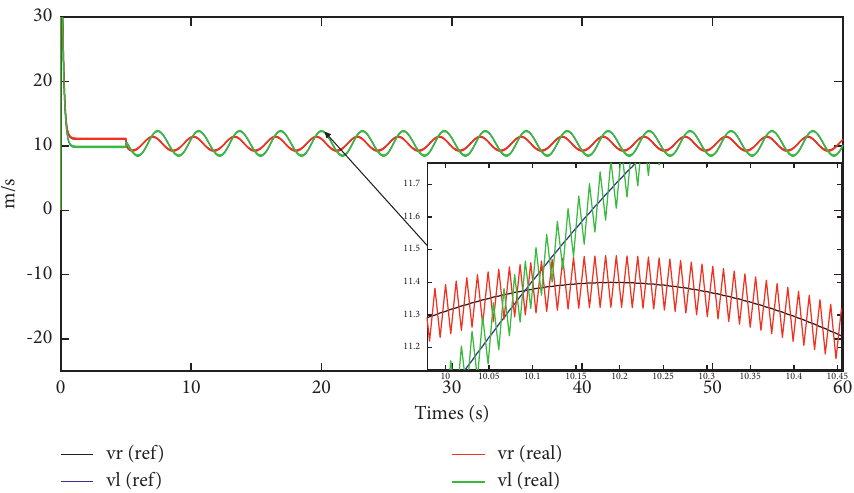
Figure 5: The real velocity of adaptive T-S fuzzy type-I for elliptical trajectory.